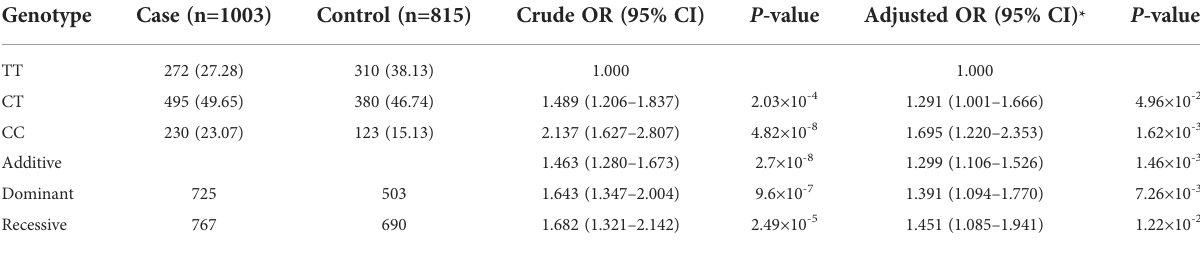
TABLE 2 Genetic association analysis between rs844649 PRDX6 - AS1 with systemic lupus erythematosus (SLE) risk in replication cohort.